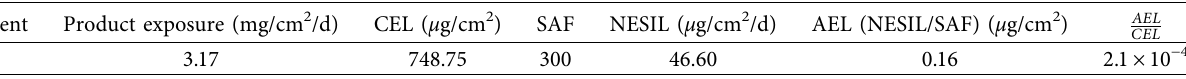
Table 5: Estimated dermal sensitization quantitative risk assessment of Hg in facial